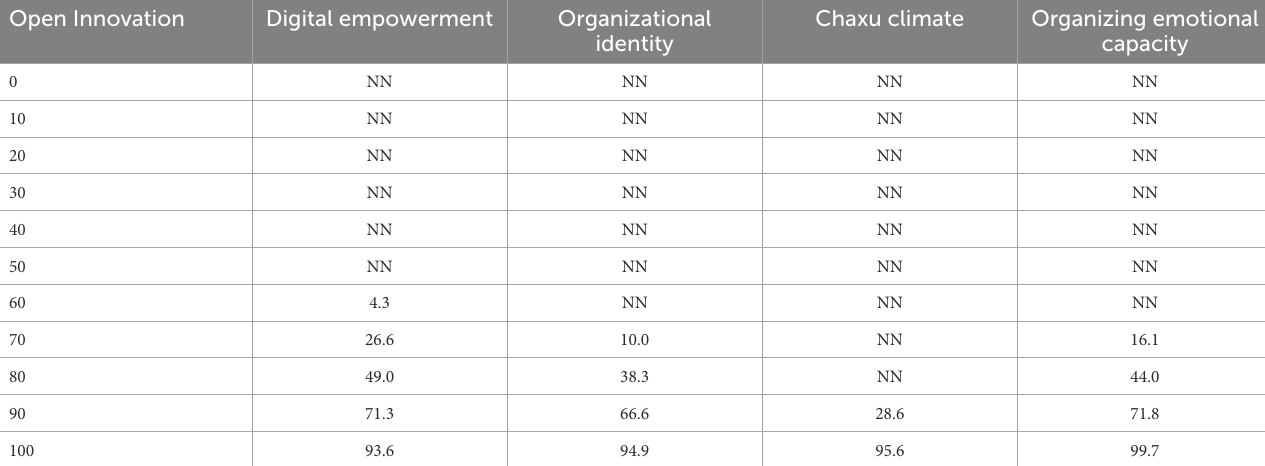
TABLE 9 Results of bottleneck level analysis of NCA